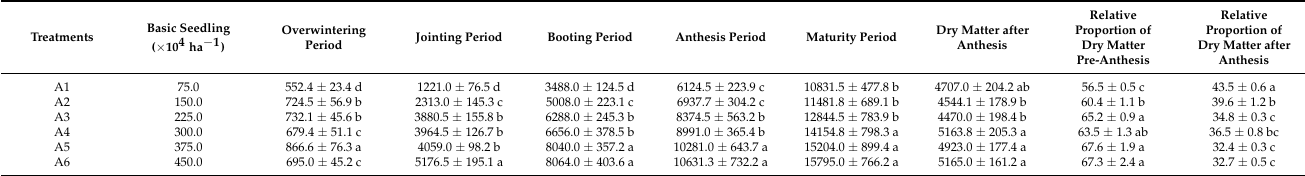
Table 3. Dynamics of dry matter accumulation in different density treatments (kg ha − 1 ).